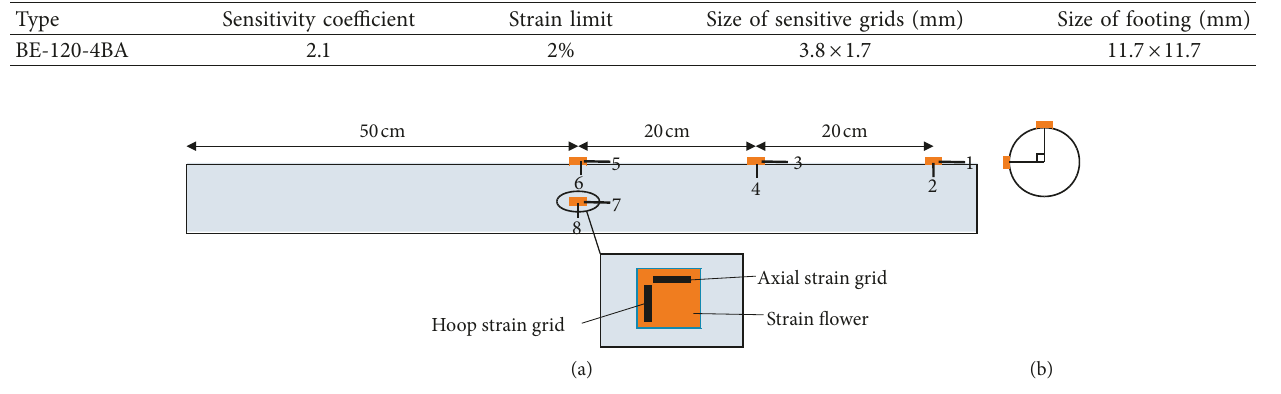
Figure 2: Schematic diagram of impact experiment of the buried pipeline. (a) Front view. (b) Top view. Table 2: Strain gauge technical parameters.